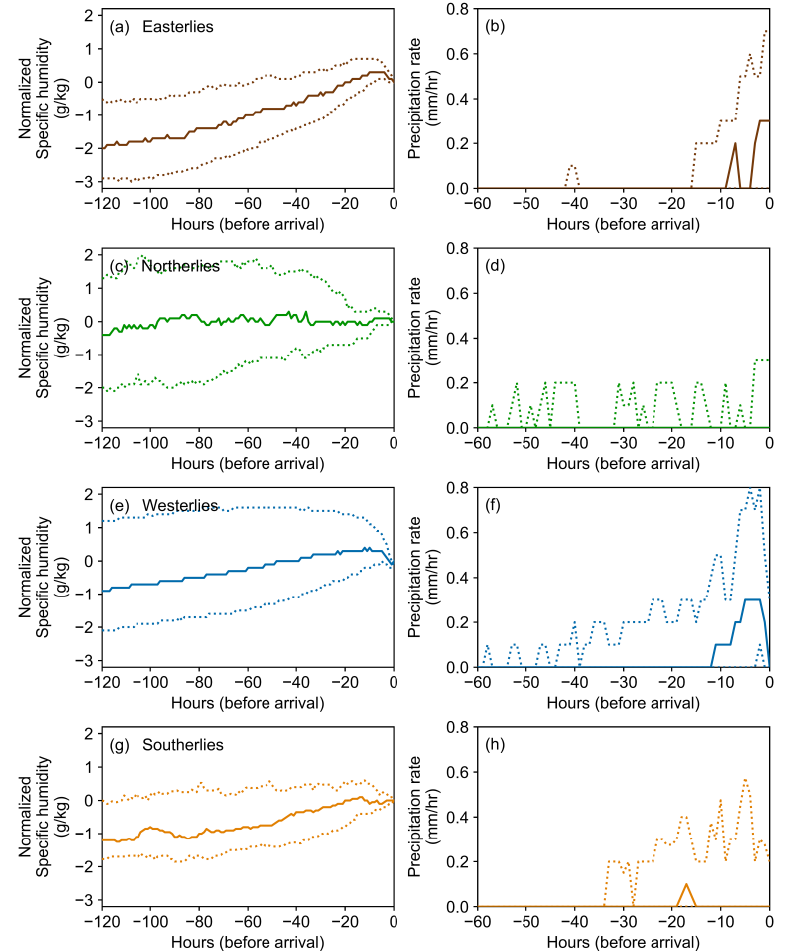
Figure 6. Rainout characteristics in GDAS-modeled trajectories. Median (solid lines) and lower/upper quartile (dotted lines) values of specific humidity (normalized to initial back-trajectory value) (a, c, e, and g) and precipitation rate (b, d, f, and h) in each hour along trajectories in the clusters of distal easterlies (a and b), northerlies (c and d), westerlies (e and f), and southerlies (g and h). The decrease in the proportion of distal westerly-derived precipitation implies that precipitation derived from secondary transport pathways become more important, in particular, the distal